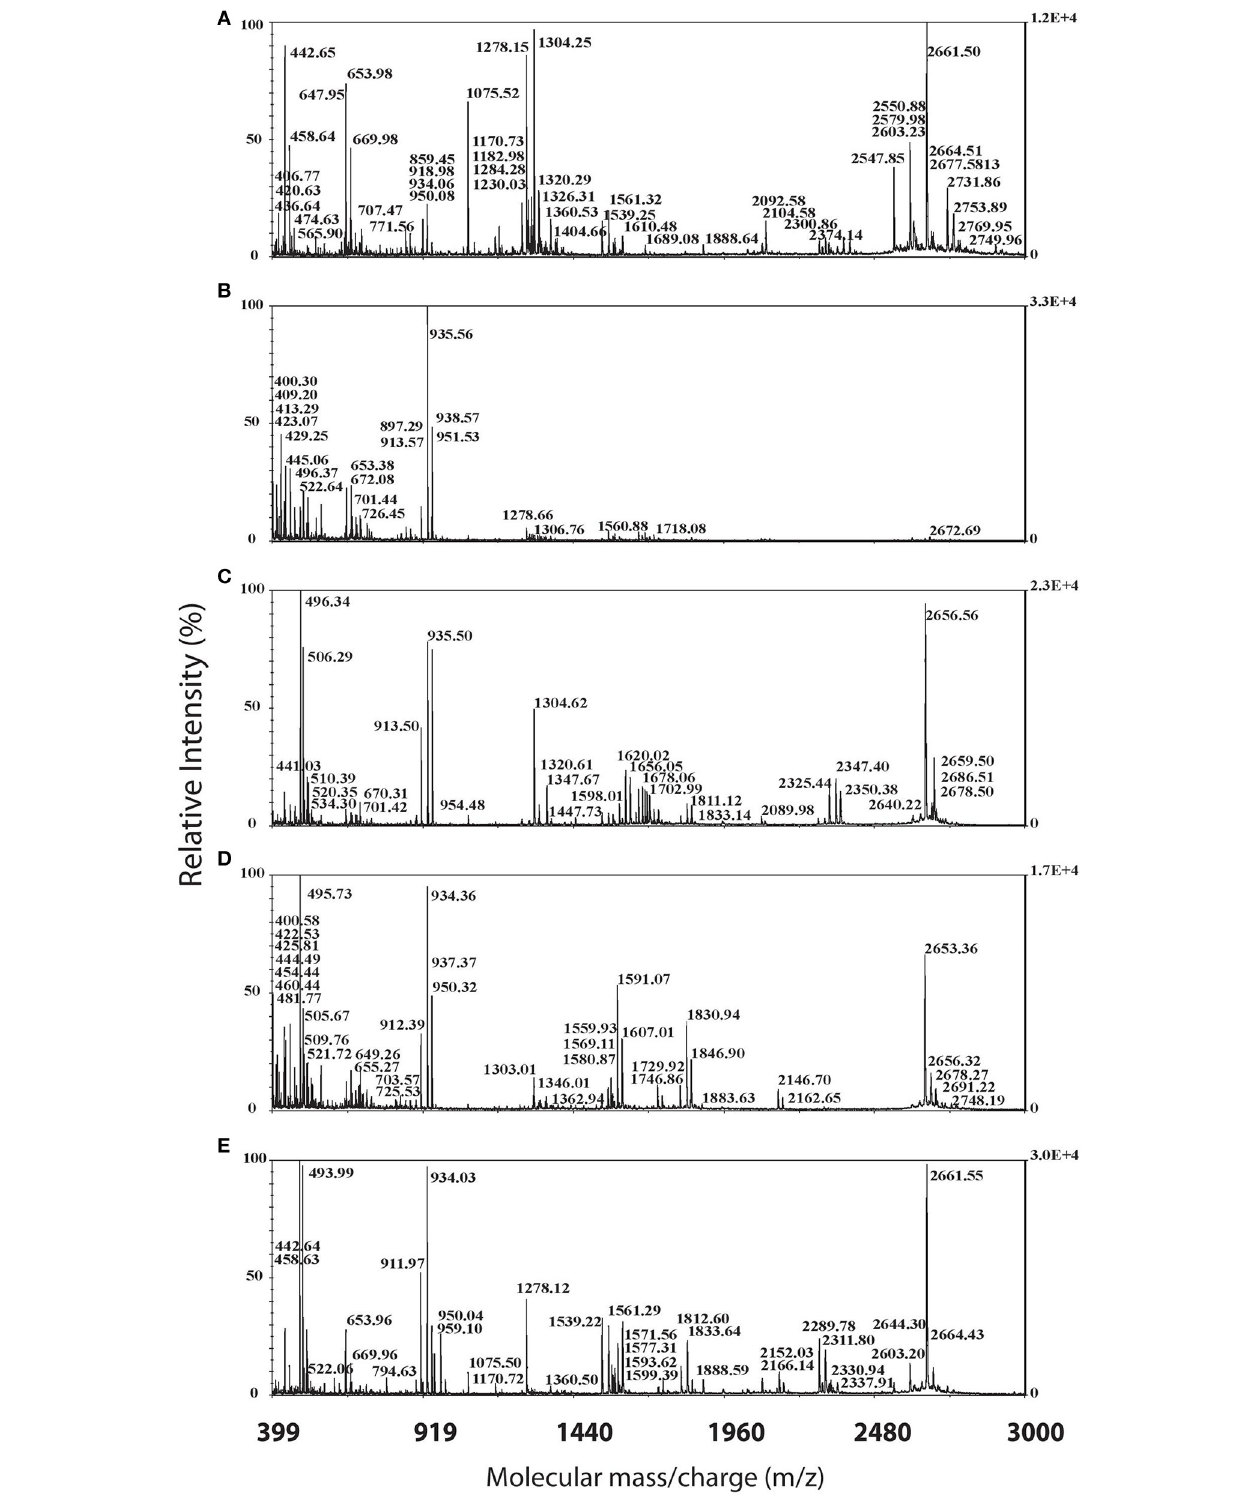
FIGURE 2 | Sample MALDI-TOF spectra of α -cyano peptide profiles for representative individuals of the five sampled regions. Spectra, from top to bottom represent: (A) SW Costa Rica (Pavones, Sample 2183), (B) SE Costa Rica and Panama (Playa Bandera, Sample 2011), (C) NW Costa Rica (Tilaron Sample 2381), (D) NE Costa Rica (Manzanillo, Sample 2374), and (E) Central Panama (Santa Fé, Sample 2130).